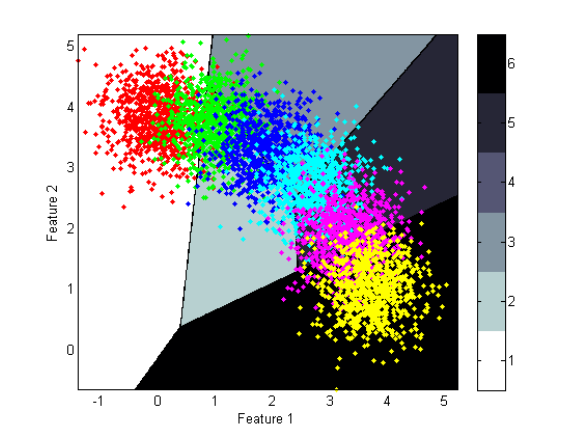
Figure 5: Decision boundaries of the one-vs.-one SVM classifi- cation model for the simulated data